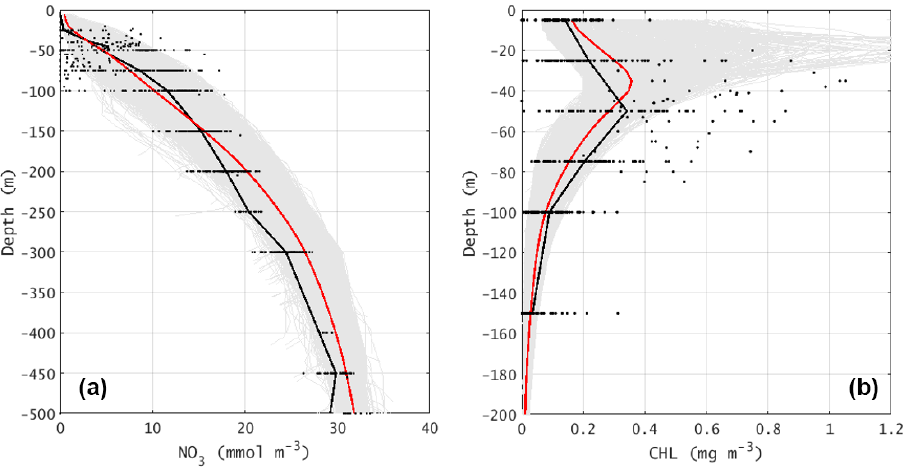
Figure 7. The vertical profiles of (a) nitrate concentration (unit: mmolm − 3 ) and (b) chlorophyll concentration (unit: mgm − 3 ). In both plots, the black dots are the observation values (see Fig. 1b for stations). The gray area shows the envelope for all model stations in the same area and month, while the red lines are the area-mean profiles.